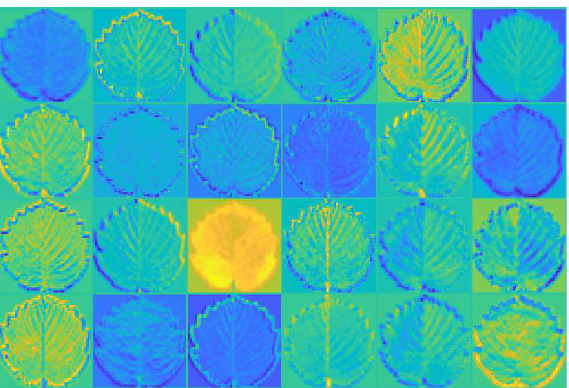
Figure 3. The first 24 feature maps of layer 15 of ResNet50 for a plant